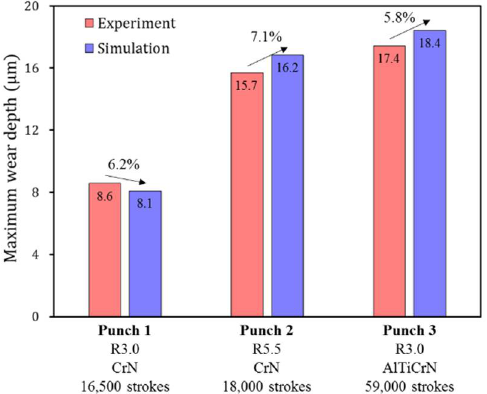
Figure 16. Difference in maximum wear depths between experiments and simulations.